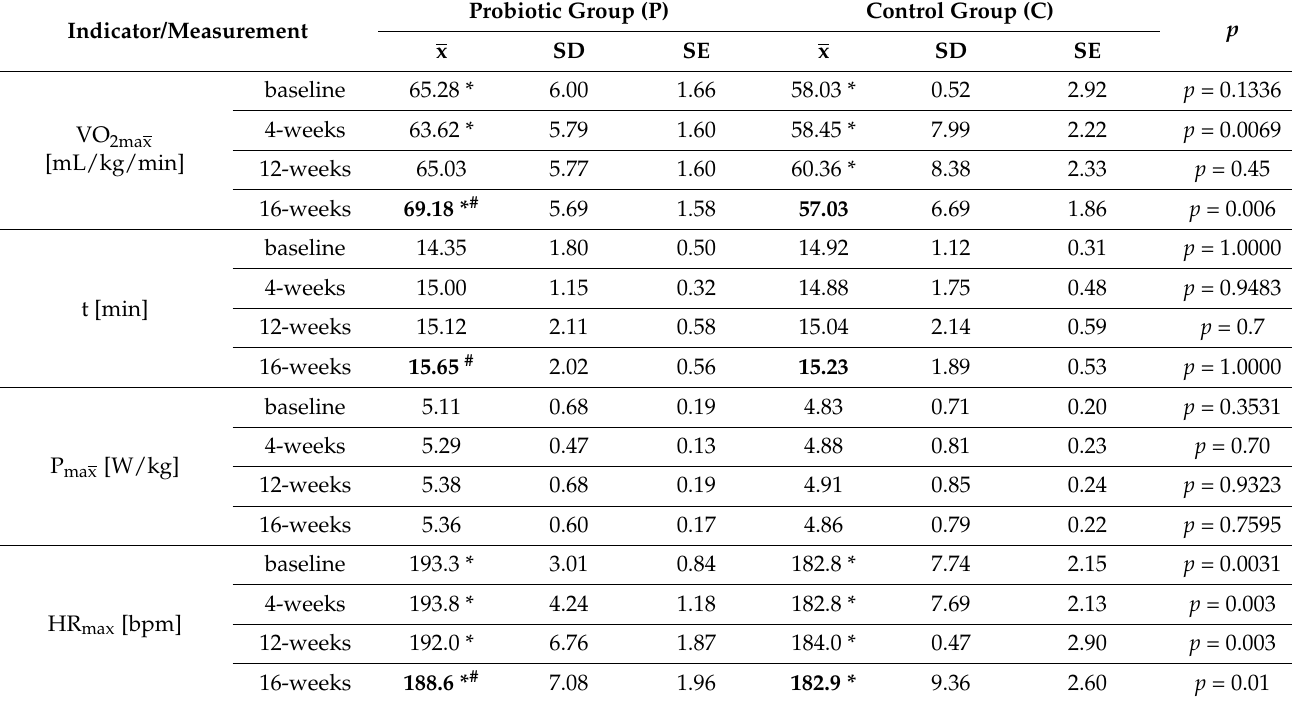
Table 1. Maximal oxygen uptake (VO 2max ), exercise duration (t), maximum power (P max ), and maximal heart rate (HR max ) during the aerobic test at follow-up measurements during supplementation